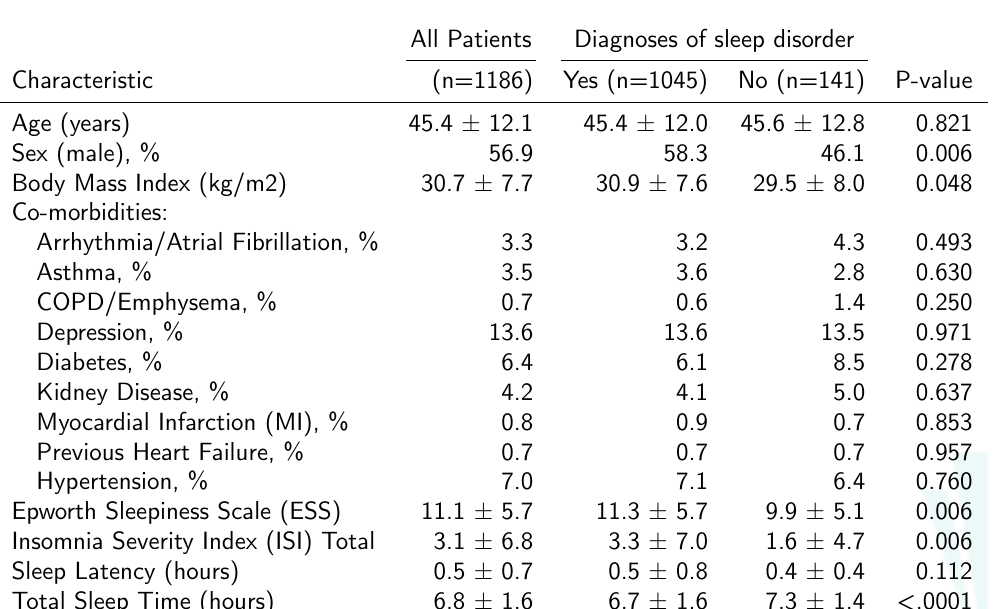
Table 1: Patient characteristics from the chart review All